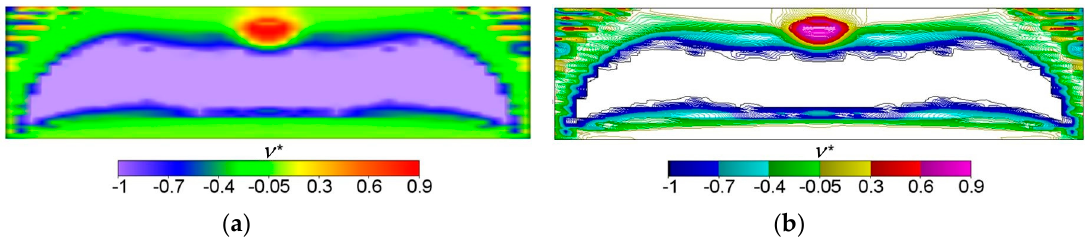
Figure 6. ( a ) Volume-render and ( b ) contour views of optimal distribution of the optimal Poisson’s ratio ν *.